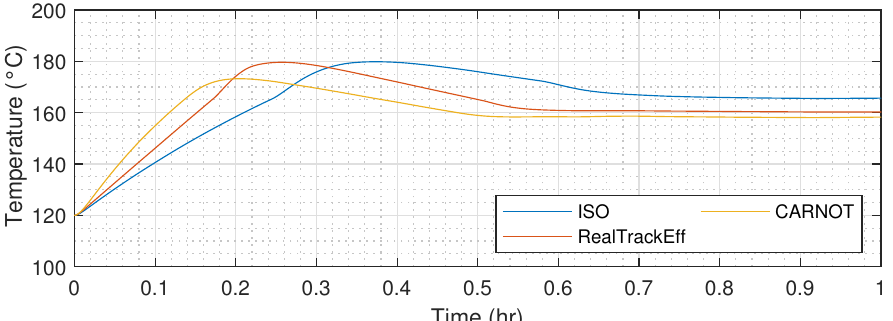
Figure 15. Tank average temperature of the 3 modellings.